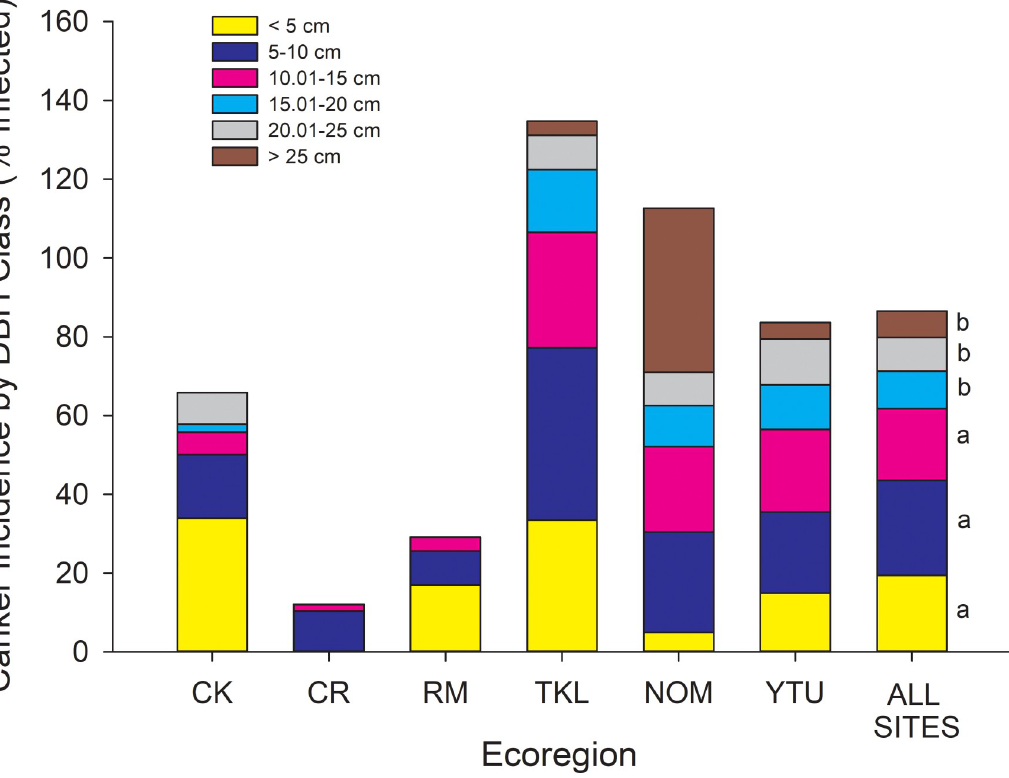
Fig 4. Incidence of canker infection by DBH class for each ecoregion and as an average across all 88 sites (last column). For the last column, size classes sharing similar letters are not different at P < 0.05 (ANOVA, F 5,291 = 5.42, P < 0.0001). CK = Cook Inlet, CR = Copper River, RM = Ray Mountains, TKL = Tanana Kuskokwim Lowlands, NOM = North Ogilvie Mountains, YTU = Yukon Tanana Uplands. The absence of size classes within ecoregions is because no trees were found within that size class, or that none of the trees within that size class were